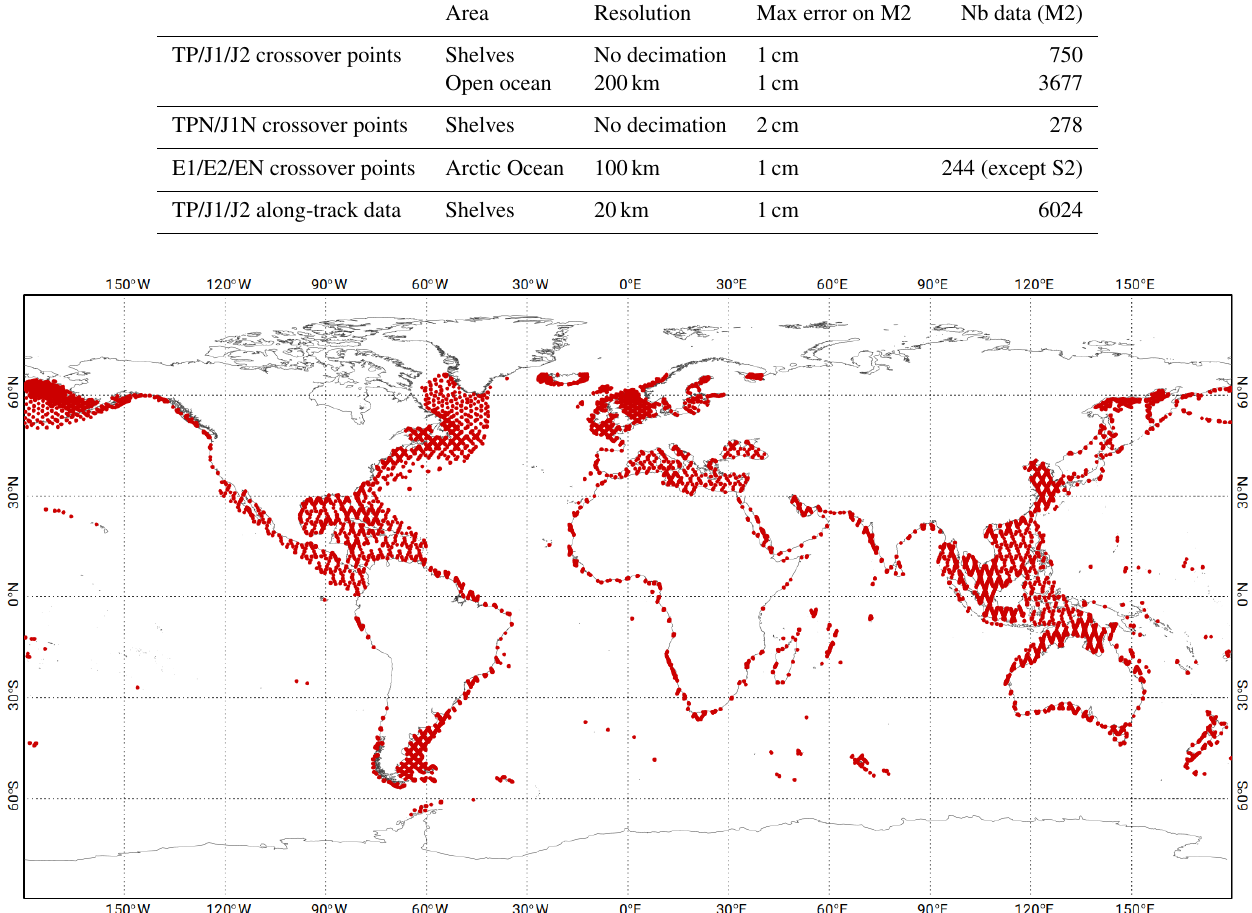
Figure 10. TP/J1/J2 along-track data selected for the data